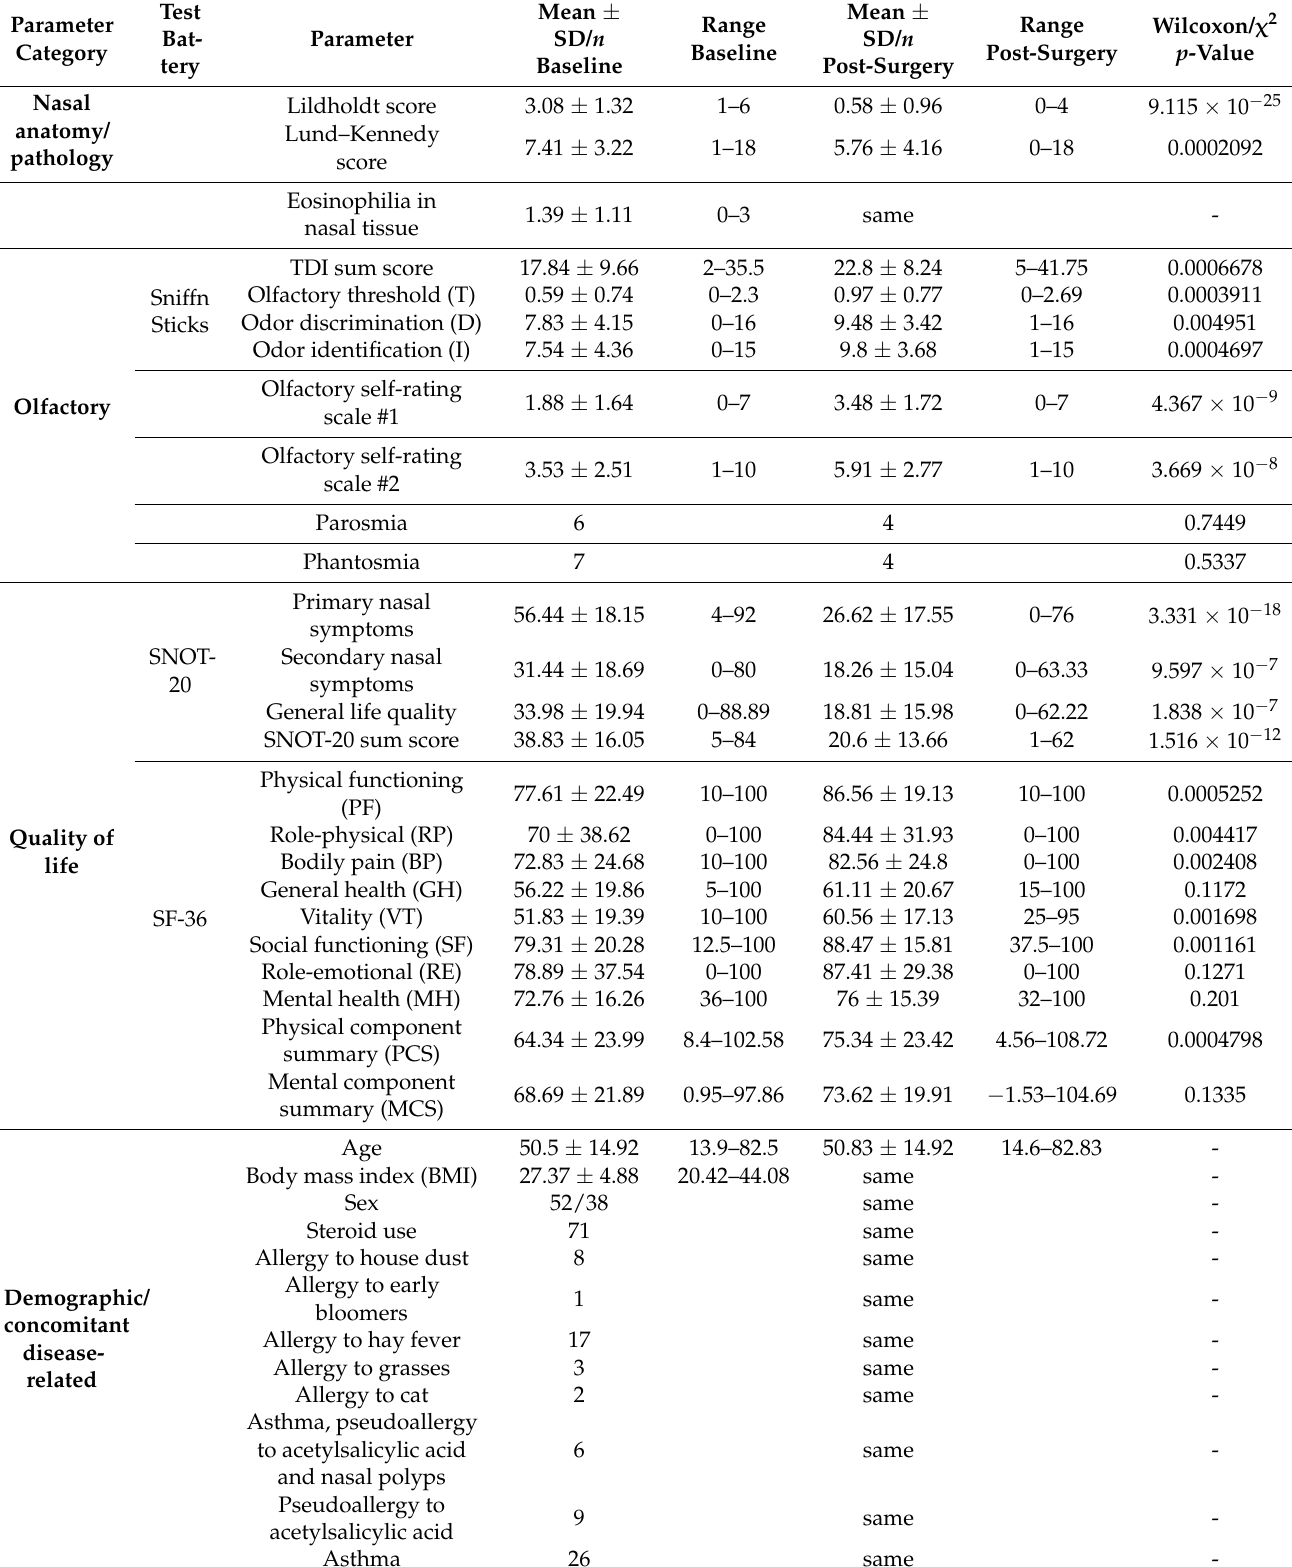
Table 1. Basic descriptive statistics of d = 37 parameters of four categories related to (i) nasal anatomy, (ii) olfaction, (iii) quality of life, and (iv) demography or concomitant diseases and allergies affecting nasal function . If acquired before or after the surgery, differences were explored using Wilcoxon–Mann–Whitney U tests for interval or ordinal variables and χ 2 tests for binary (yes/no) or categorial variables. Only p -values are shown for these explorative